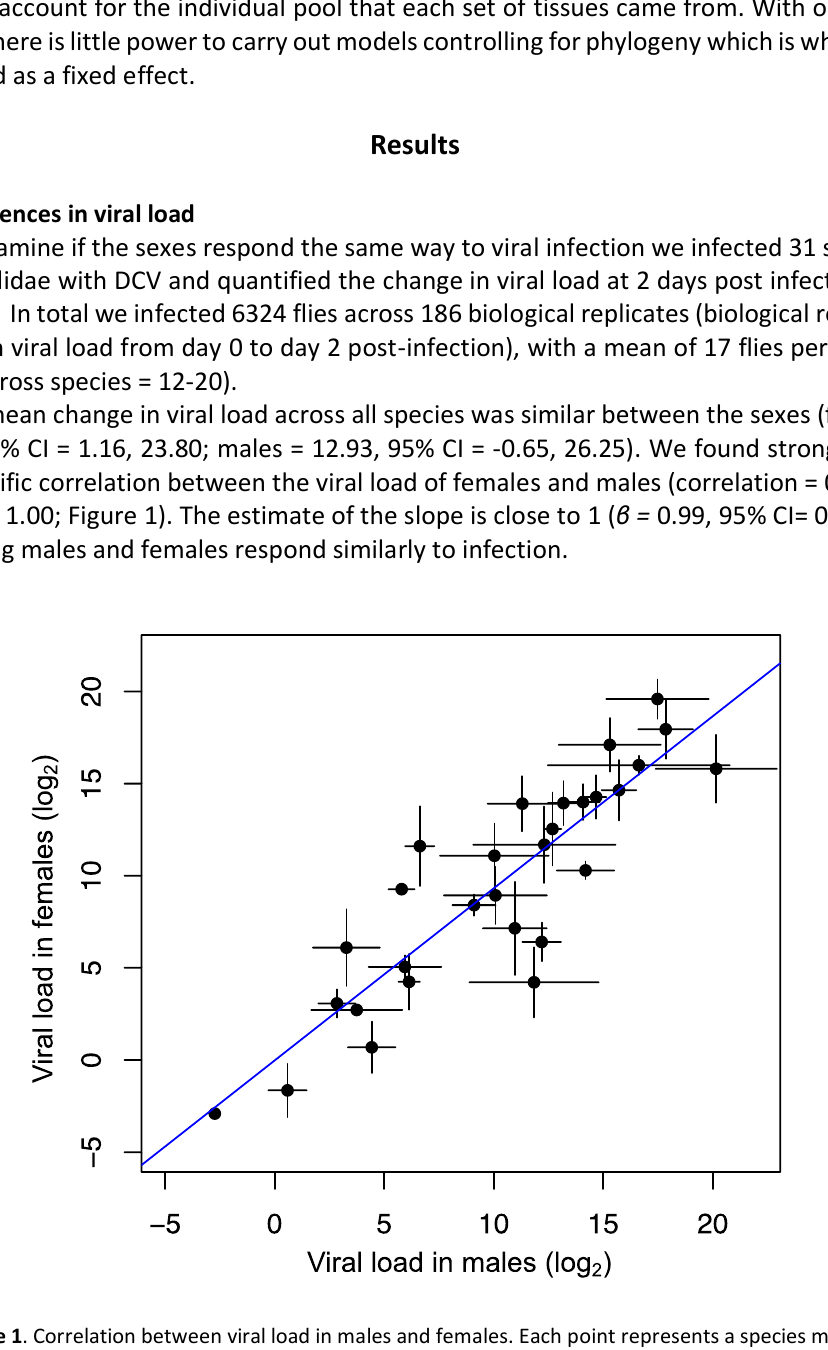
Figure 1 . Correlation between viral load in males and females. Each point represents a species mean, error bars show standard errors and the trend line is estimated from a linear